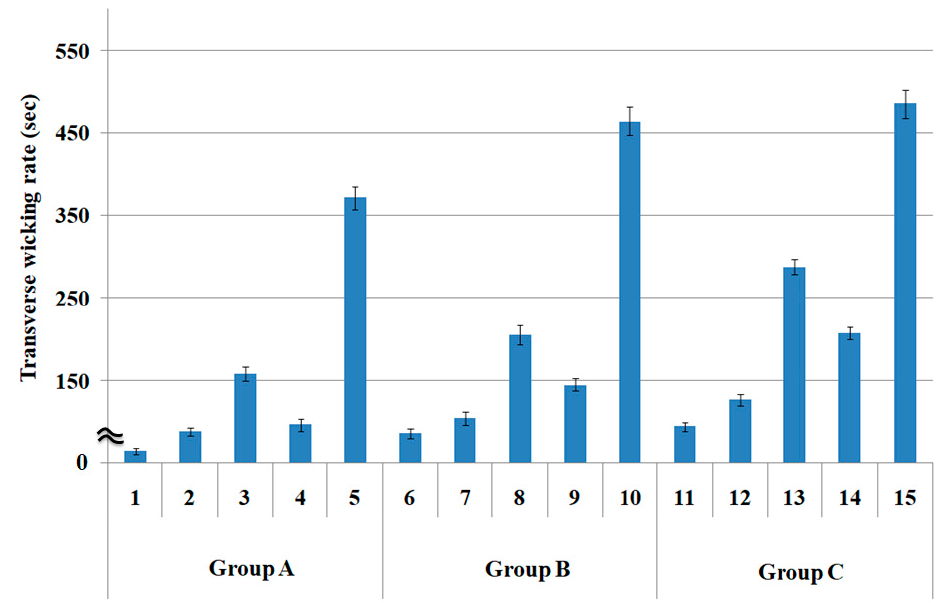
Figure 3. Transverse wicking rates of the fabric specimens ( p <